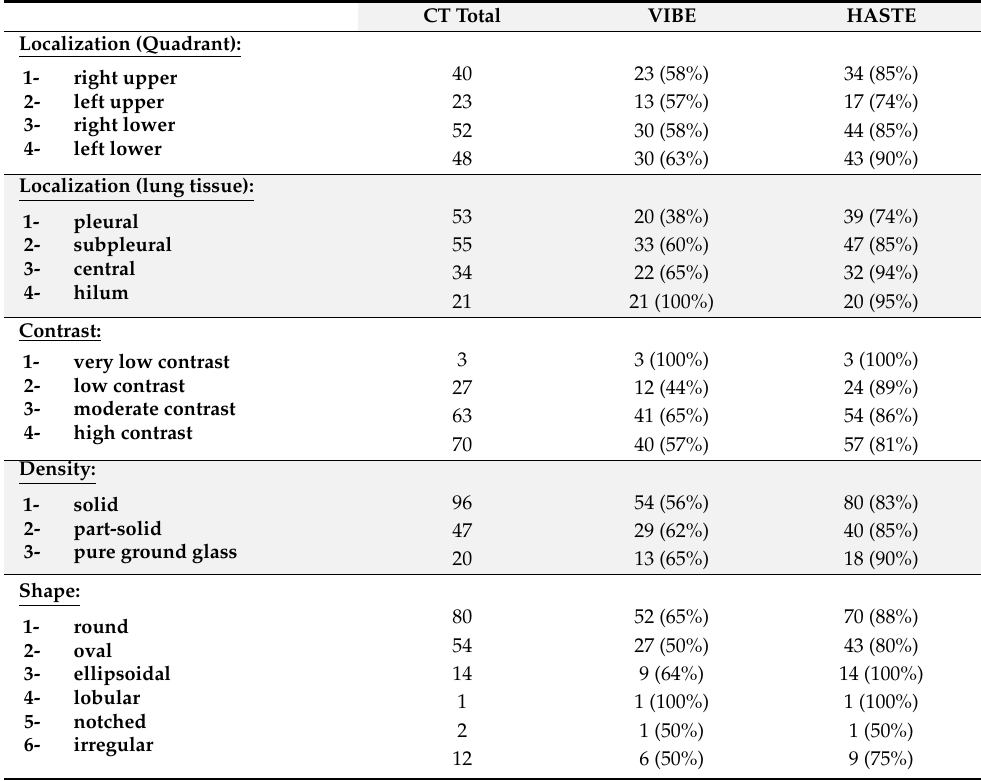
Figure 4. Sizes of missed lung nodules at ( A ) MRI VIBE ( n = 96) and ( B ) MRI HASTE ( n = 138) measured on initial CT. Average size (broken line) of nodules was 3.2 mm (range 1–8 mm) in MRI VIBE and 3.6 mm (range 1–9 mm) in MRI HASTE. Table 3. Localization and characteristics of missed lung nodules at MRI VIBE and MRI HASTE sequence corresponding to